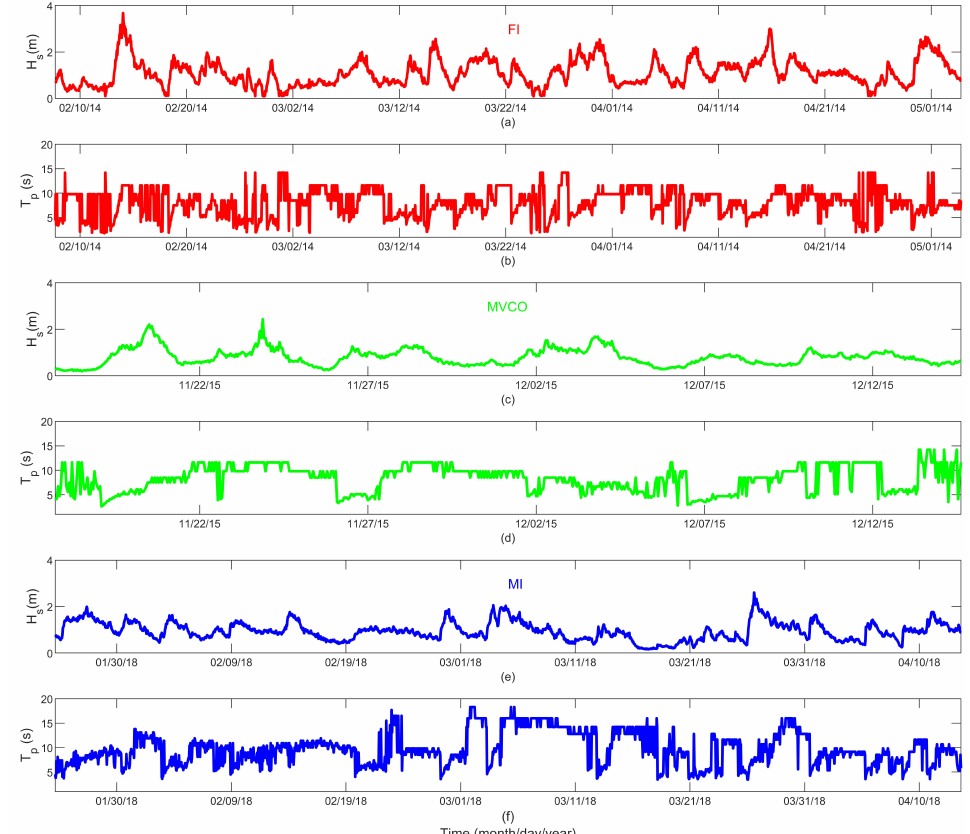
Figure 4. Datasets of significant wave height and peak wave period estimated from the upward- looking acoustic Doppler current profile respectively from ( a ) and ( b ) Fire Island, ( c ) and ( d ) MVCO, ( e ) and ( f ) Matanzas